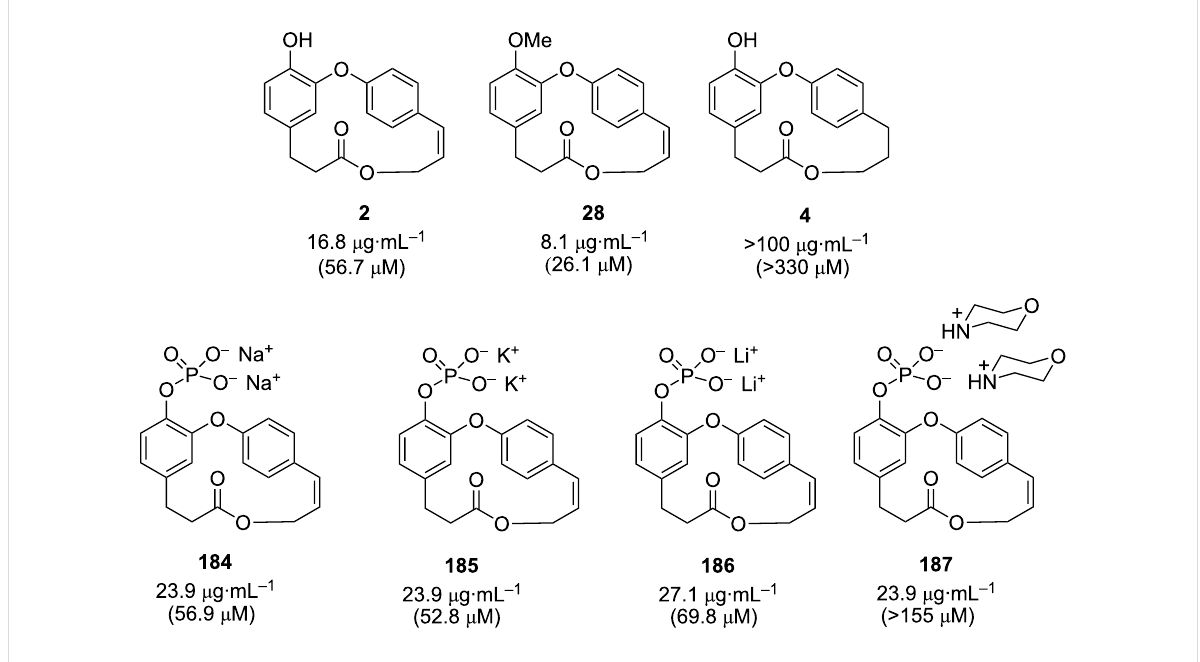
Figure 2: ED 50 values of the combretastatin D family against murine P388 lymphocytic leukemia cell line (approximated values of molar concentra- tion after conversion) [55].